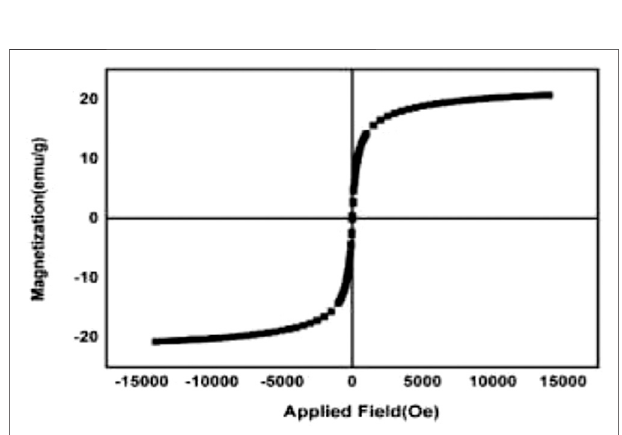
FIGURE 5 | VSM analysis of